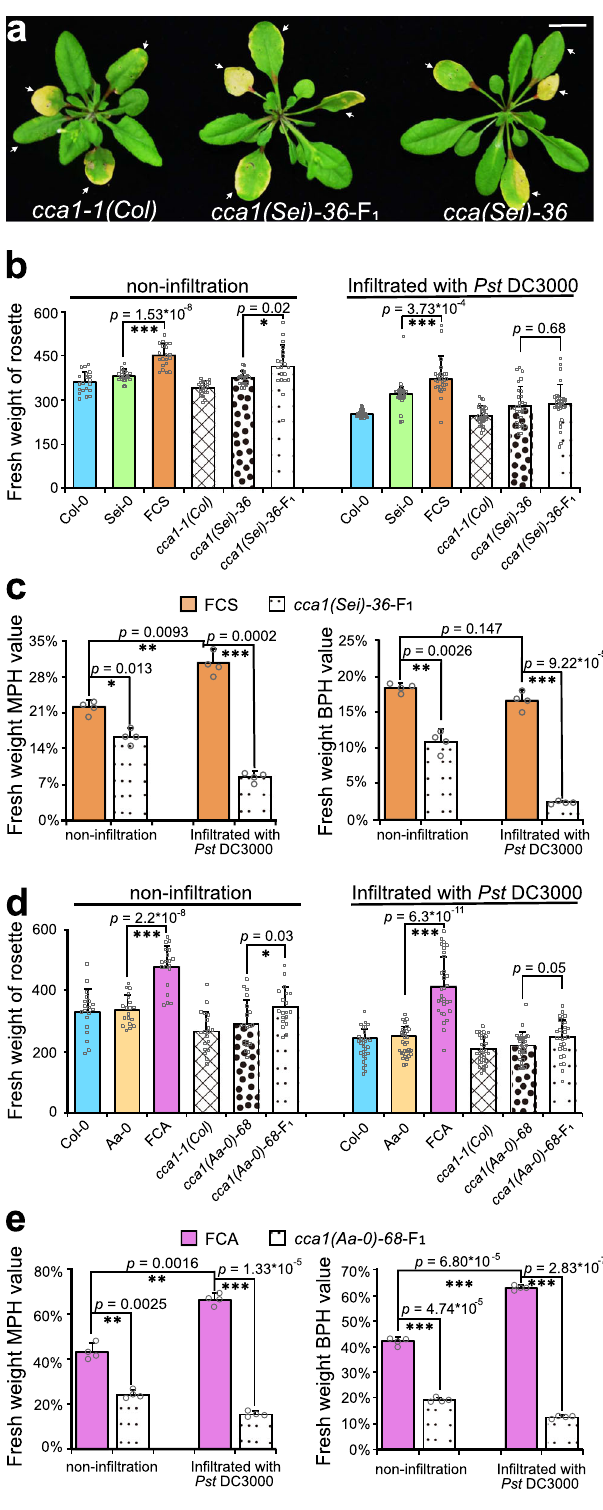
Fig. 3 CCA1 confers defense heterosis in hybrids without growth vigor costs. a Phenotypes of the whole rosette of the CCA1 -mutated F 1 hybrids and parents at 5 days post in fi ltration. Arrows show the four leaves of each plant inoculated with the pathogen. The scale represents 1 cm. b , d Fresh weight of the whole rosette of wild-type and CCA1 -mutated hybrids and parents simultaneously with Pst DC3000 in fi ltration or not. 20-day-old (counted from the day the seedlings were transferred from MS plates to the soil) plants were in fi ltrated with Pst DC3000 or not in fi ltrated. The fresh weight of whole rosette was calculated 5 days later for both noninoculated and inoculated genotypes. Data are shown as the mean ± SD ( n = 20 plants for each genotype without Pst DC3000 in fi ltration, and n = 30 plants for each genotype with Pst DC3000 in fi ltration). c , e MPH and BPH values of wild-type and CCA1 -mutated hybrids calculated by whole rosette fresh weight at the same time without (nonin fi ltration) or with Pst DC3000 in fi ltration. Data are shown as the mean ± SD. The results in c and e are representative of three independent experiments, with measurements that were taken from independent samples grown and processed at different times. * p value < 0.05; ** p value < 0.01; and *** p value < 0.001 (two-tailed Student ’ s t